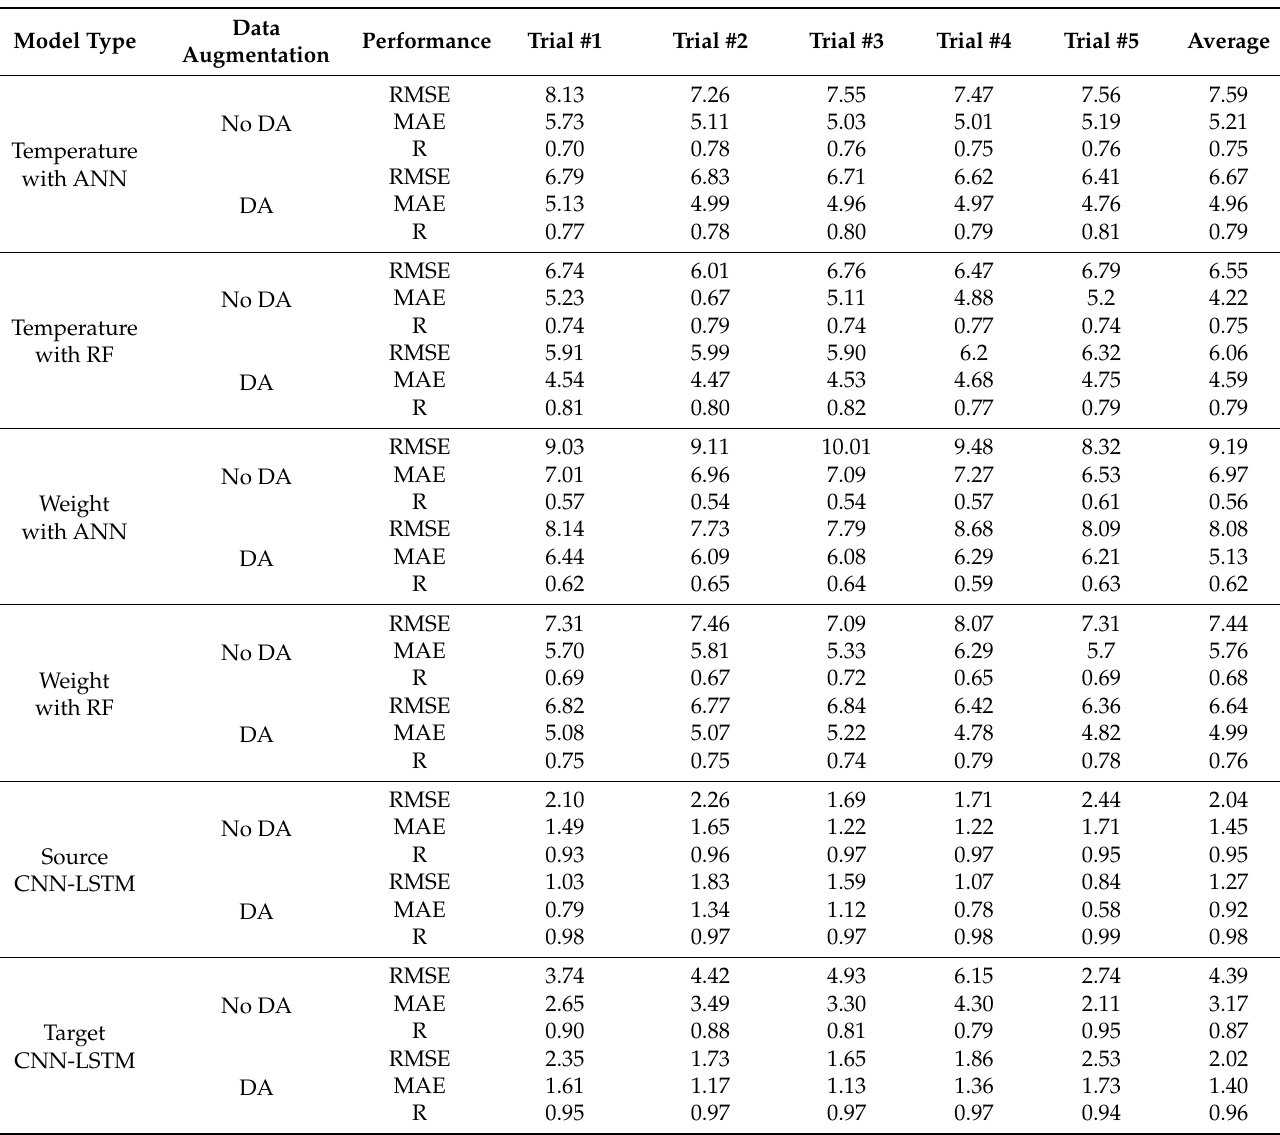
Table 3. The overall result of general machine learning and transfer-learning-based CNN-LSTM model using temperature and weight loss data with and without data augmentation